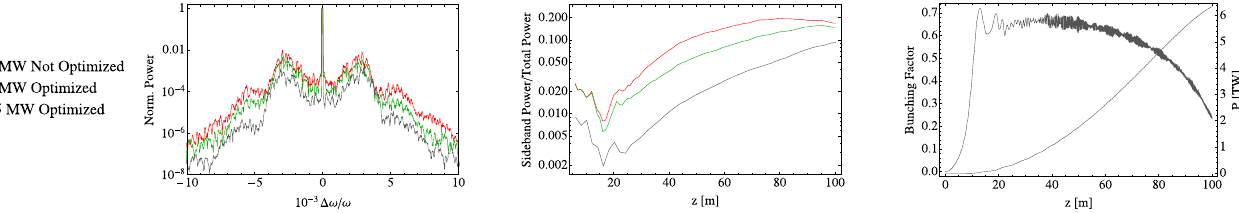
FIG. 6. (left) Spectrum at half the undulator length and fractional sideband power (middle) for the time independent optimized case and fully time dependent optimized for 5 and 25 MW input seed power and 1.5 MeVenergy spread. Sideband power grows faster in the time independent optimized case, leading to particle detrapping and early saturation of the tapered FEL. (right) Bunching factor and power evolution for the optimal 25 MW seed